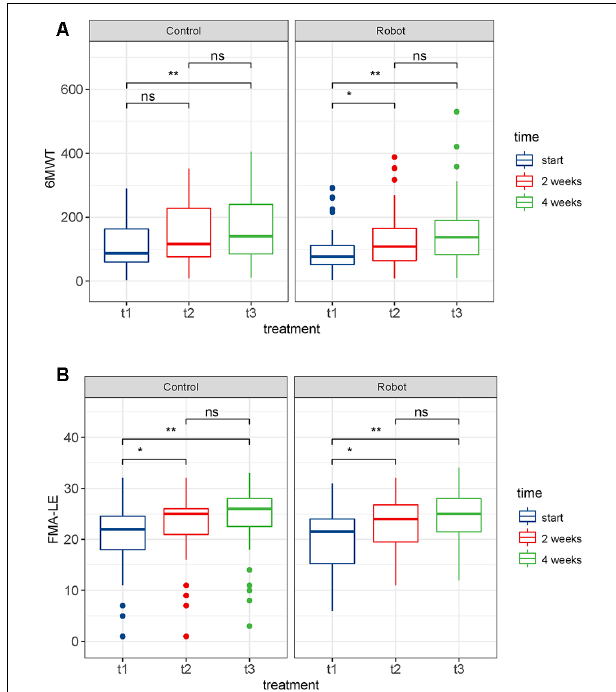
FIGURE 7 | Box plots of the differences in the outcomes at multiple time points. (A) 6-min walk test (6MWT). (B) Fugl-Meyer assessment lower-limb subscale (FMA-LE). ns: not significant, * p < 0.05, ** p < 0.01; t1: before treatment, t2: after 2 weeks of treatment, t3: after 4 weeks of treatment.